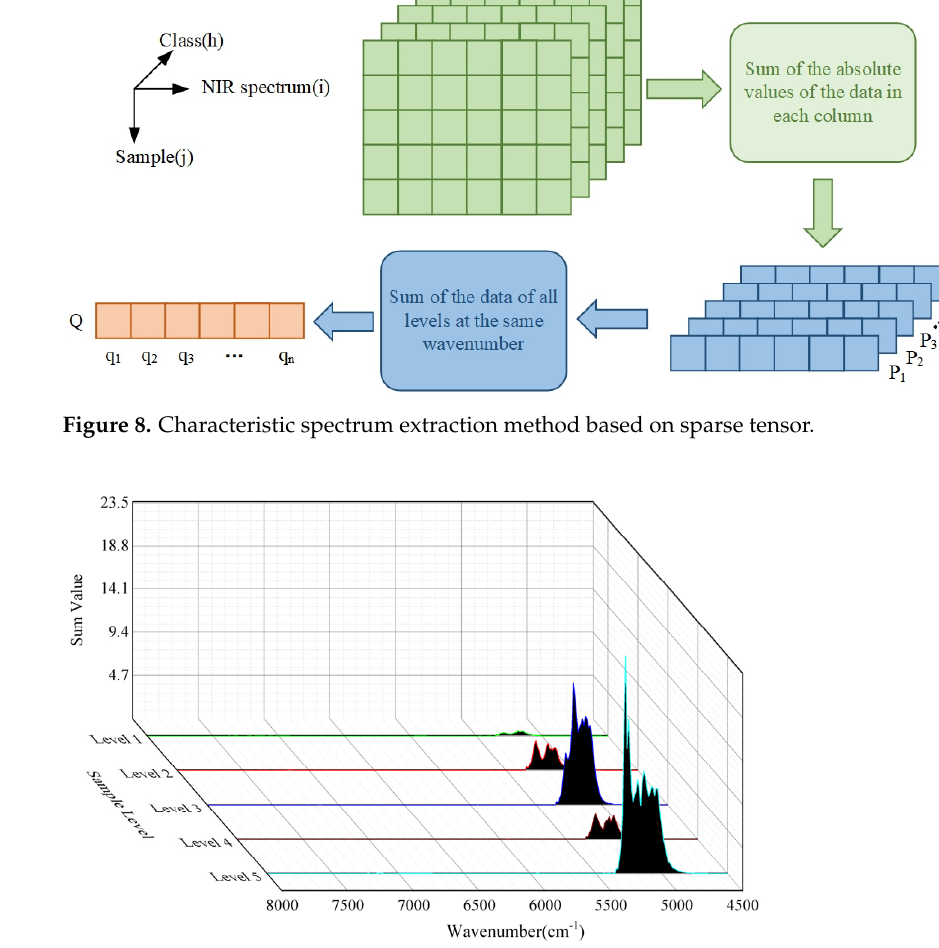
Figure 8. Characteristic spectrum extraction method based on sparse tensor.